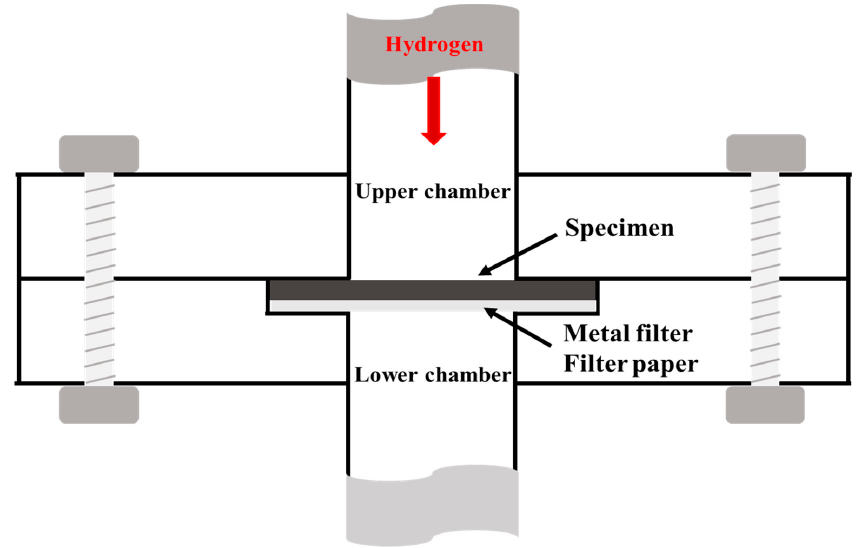
Figure 2. Schematic of the permeation test.